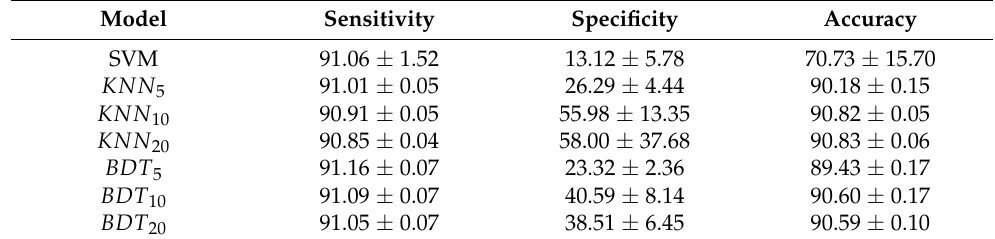
Table 6. Performance of the trained classifiers on the generated patches of the training set (%).